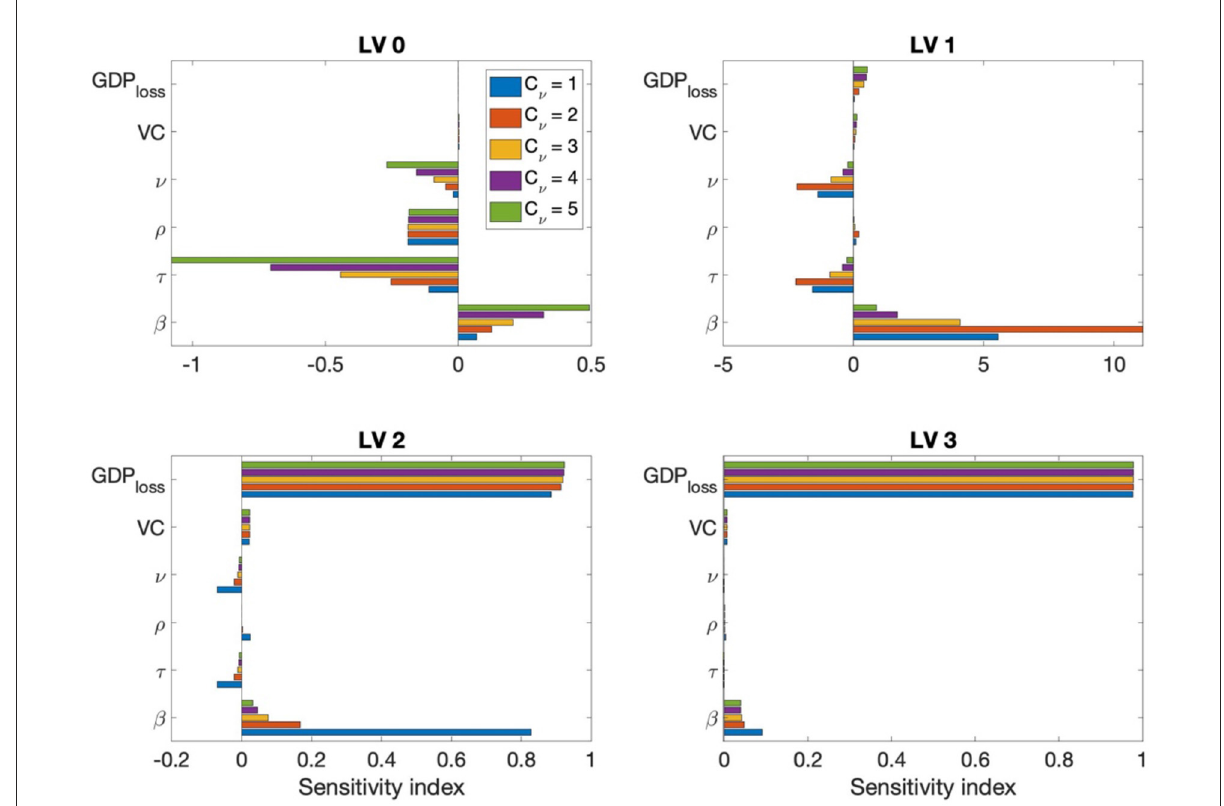
FIGURE7 Sensitivity index of β , τ , ρ , ν , the vaccine cost, and GDP loss rate for C ν = 1,2,..., 5 and each SD